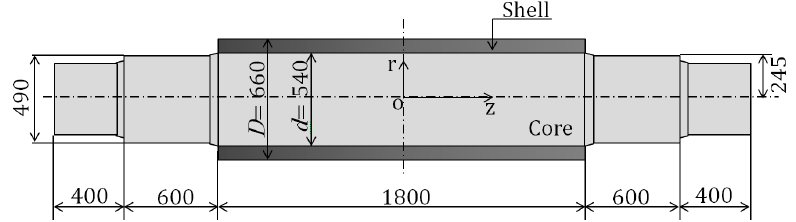
Figure 1. Model of the bimetallic roll (mm).